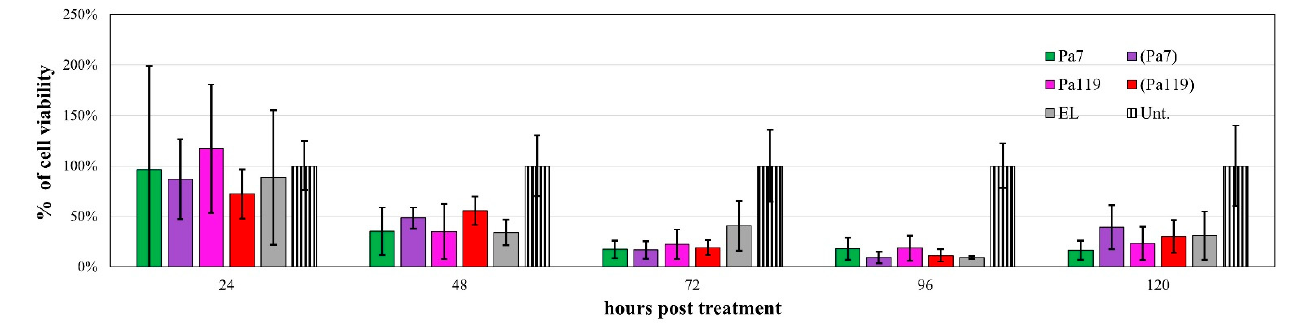
Figure 6. The bactericidal effect of the most effective concentrations of Pa7 and Pa119 up to 120 hours post-treatment. EL—empty liposomes; Pa7—Pa7 lysin in the free form; Pa119—Pa119 lysin in the free form; (Pa7)—Pa7 lysin encapsulated in liposomes; (Pa119)—Pa119 lysin encapsulated in liposomes; Unt.—untreated control. The cell viability after treatment up to 120 h is shown for the most effective concentrations of lysins in the free form (25 µg/mL) and for lysins encapsulated in liposomes (6.25 µg/mL). The represented empty liposomes (EL) formulation bars correspond to the lipidic concentration used to match the same conditions of the encapsulated lysins. The untreated control is shown as a striped bar for comparison.